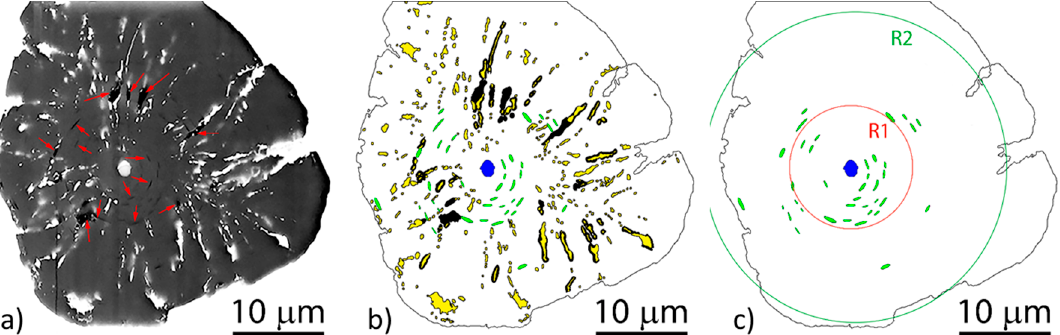
Figure 33. FIB 3D tomography of a graphite nodule: ( a ) 2-D cross-section at the center of the nodule; ( b ) a binary sketch of the same cross-section, showing the Fe particles in yellow, the nucleus in blue, radially oriented voids in black and type concentric voids in green; ( c ) the binary sketch in ( b ) only showing the concentric voids perpendicular to the radial direction in the graphite, mostly located in the R1, reproduced from [124] with permission from Elsevier.